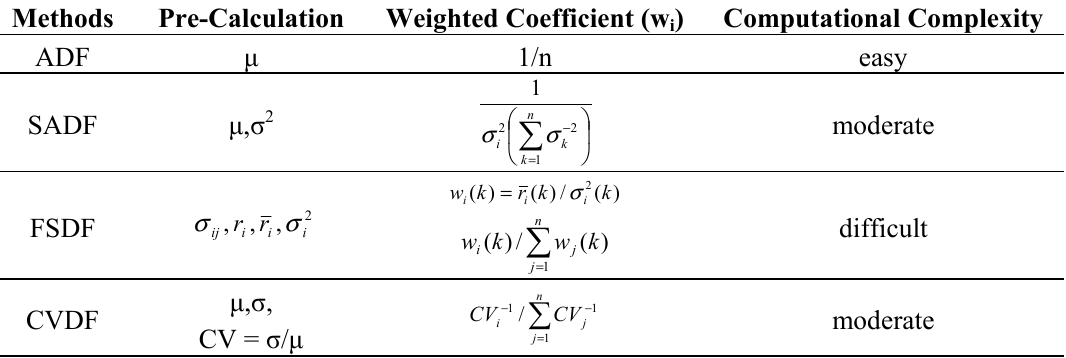
Table 6. The summary of pre-calculation, weighted coefficient and computational complexity with different data fusion methods